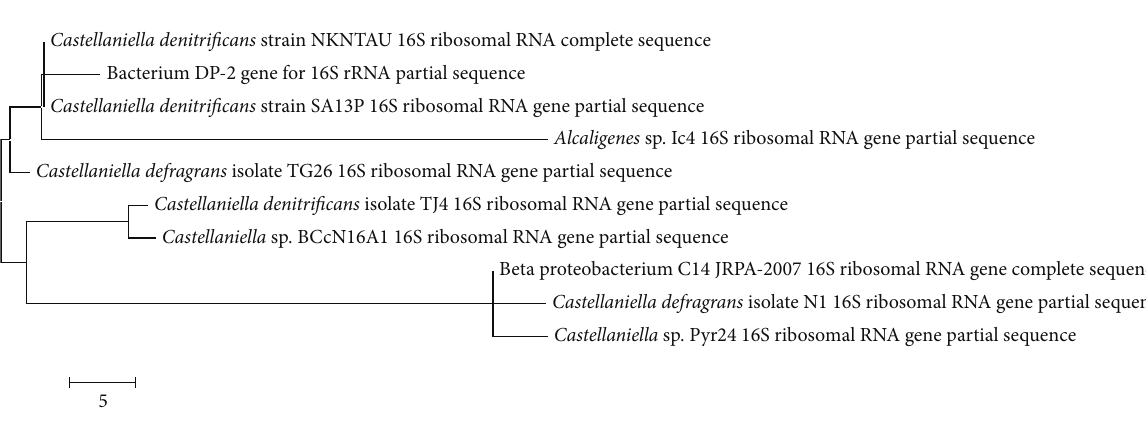
Figure 7: Molecular phylogenetic analysis of Castellaniella denitrificans SA13P by maximum likelihood